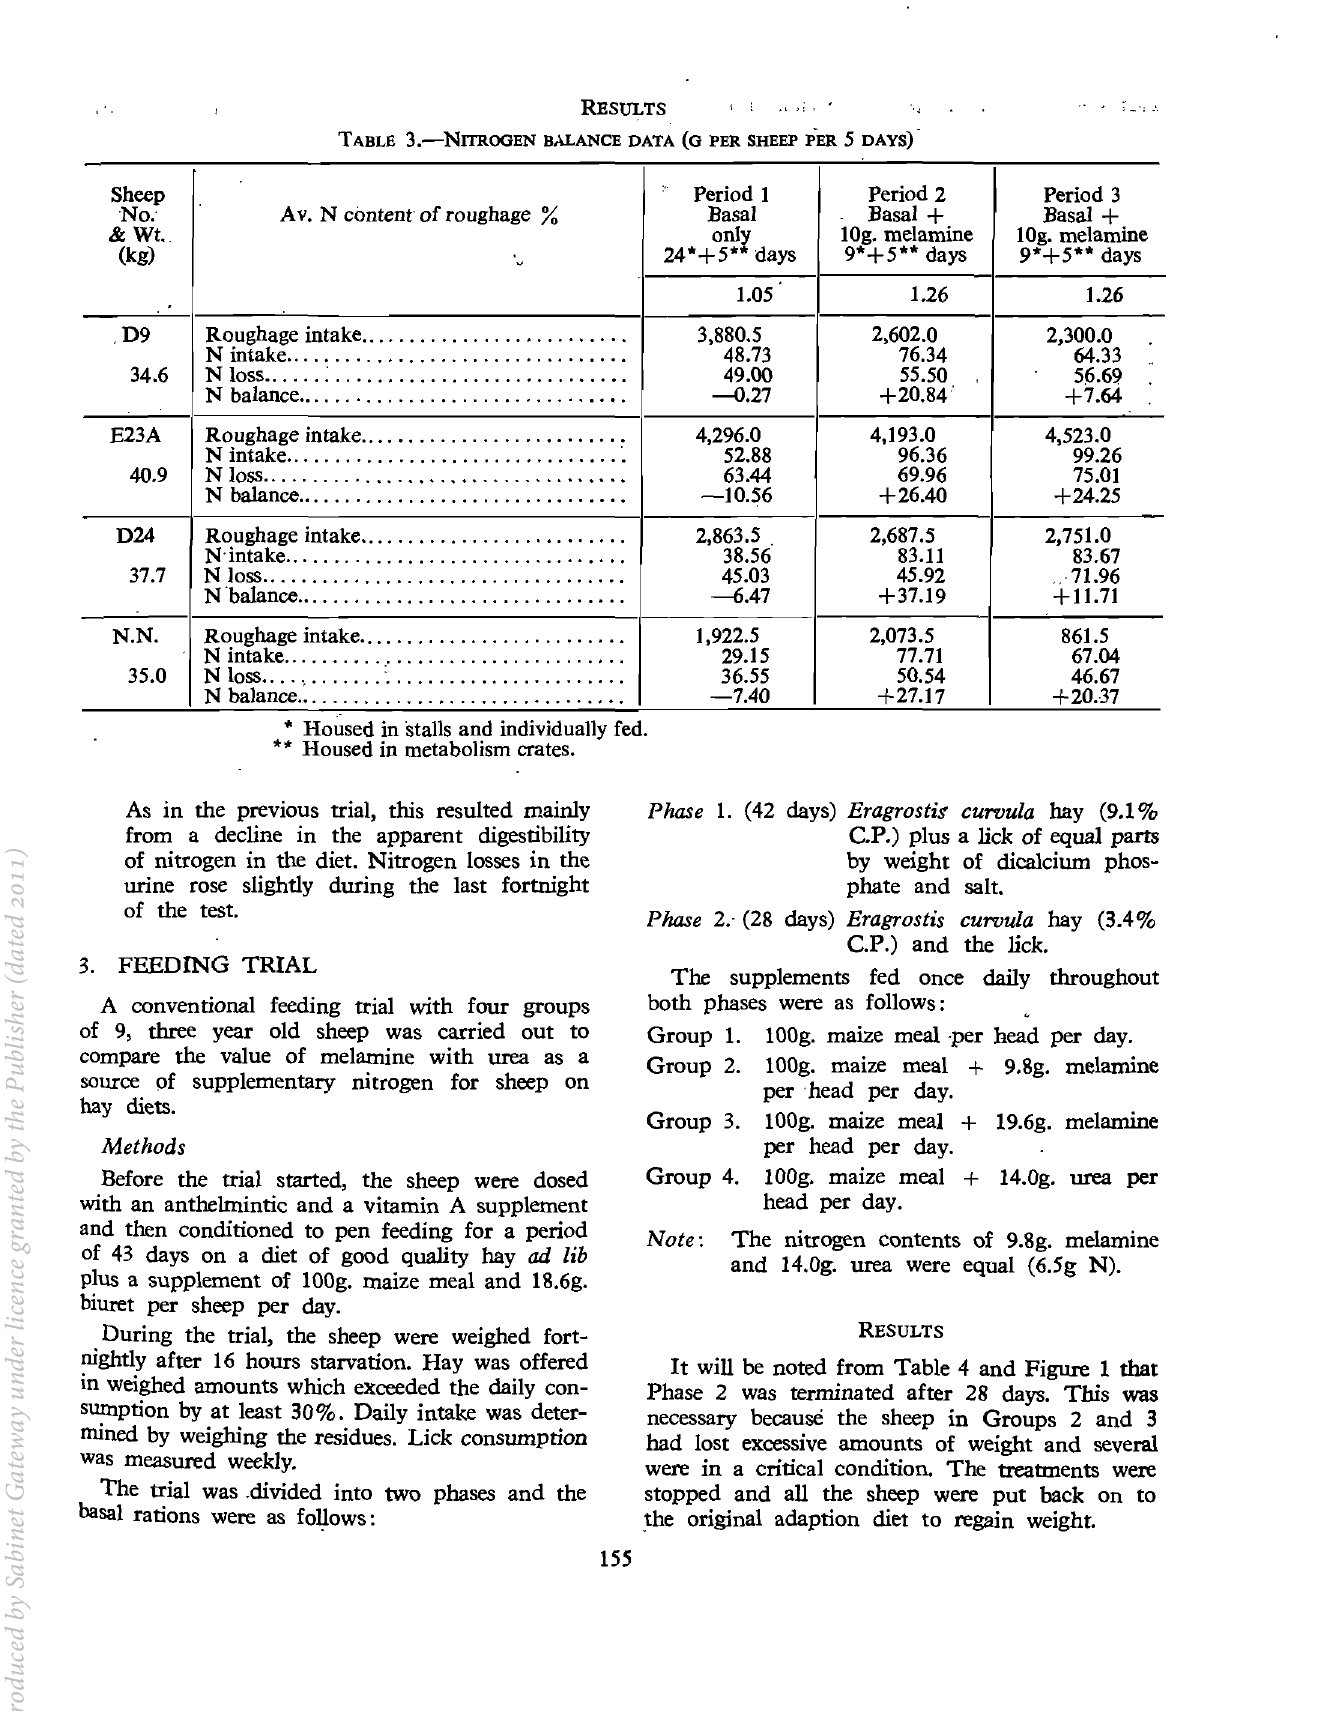
TABLE 3.-NITROGEN BALANCE DATA (0 PER SHEEP PER 5 DAYS)